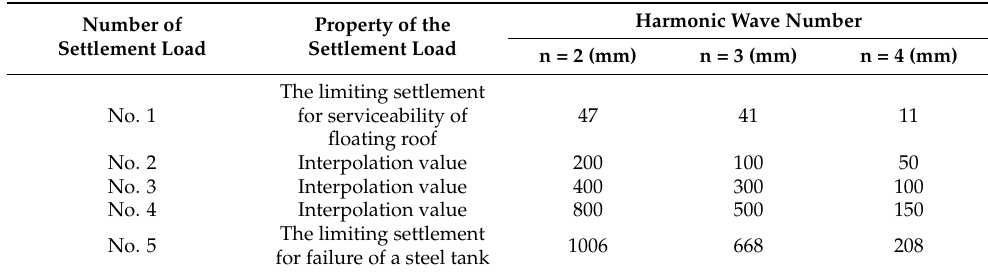
Table 6. The settlement load levels for three harmonic